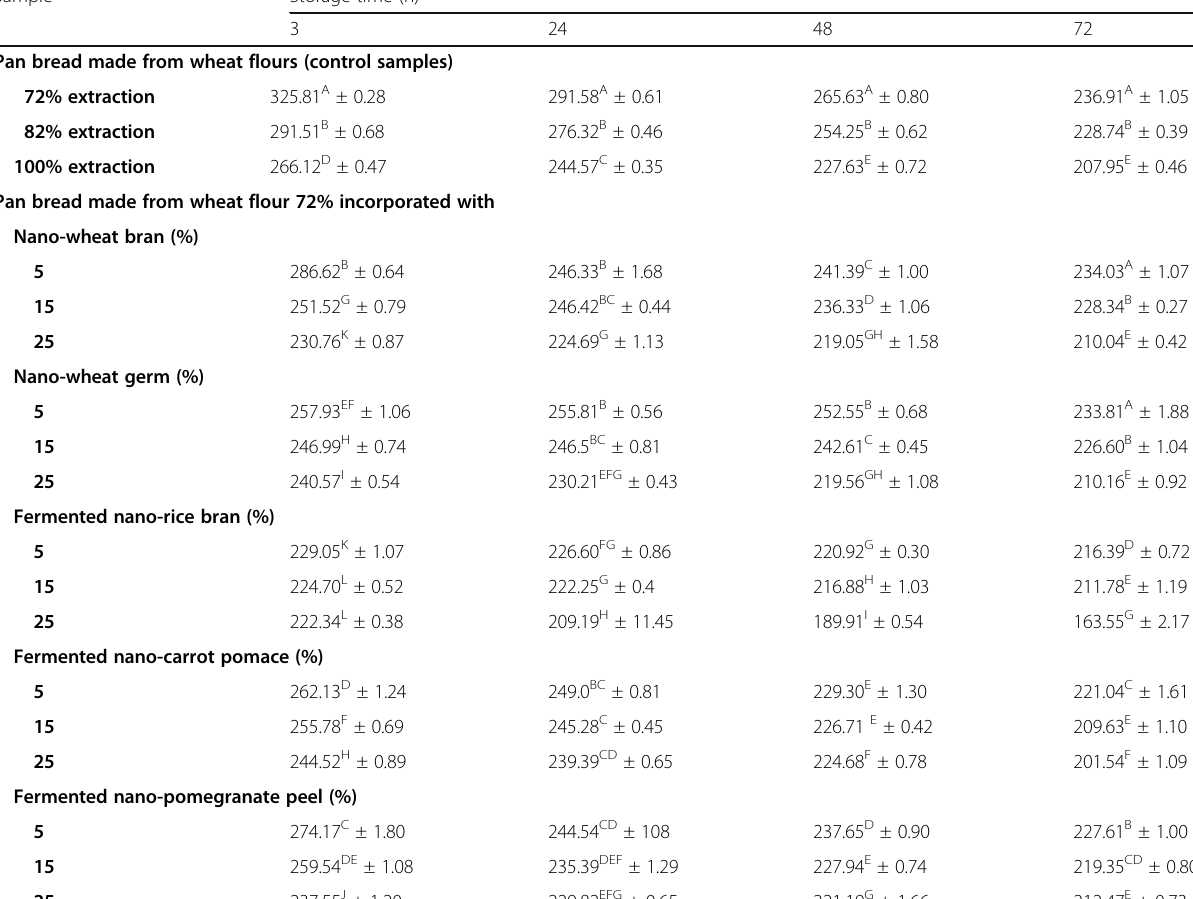
Table 5 Alkaline water retention capacity of pan bread as affected by addition of nano and fermented nano materials (%)